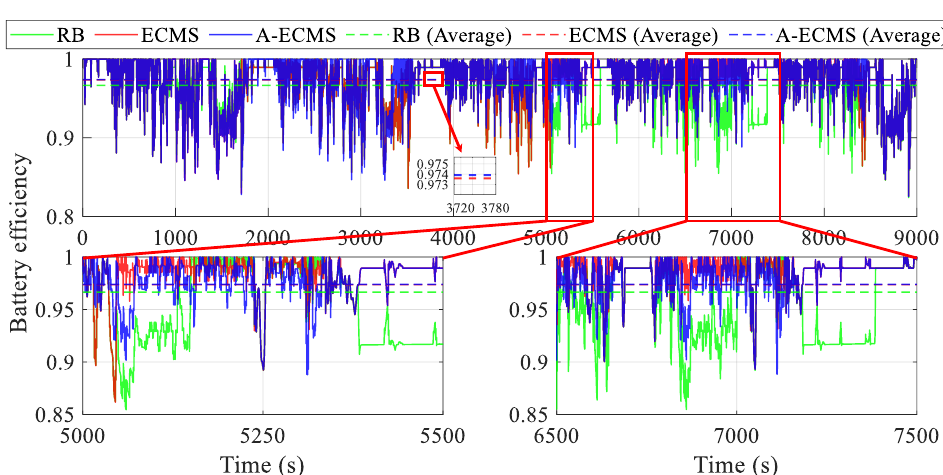
Figure 15. Curves of the battery efficiency using different